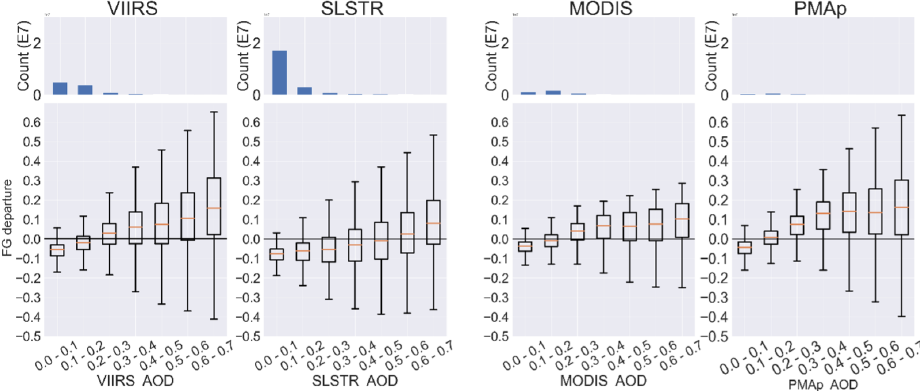
Figure 8. Global statistics of the first-guess departure (FGD) for a distinct range of AOD for the DJF (2019–2020) period over